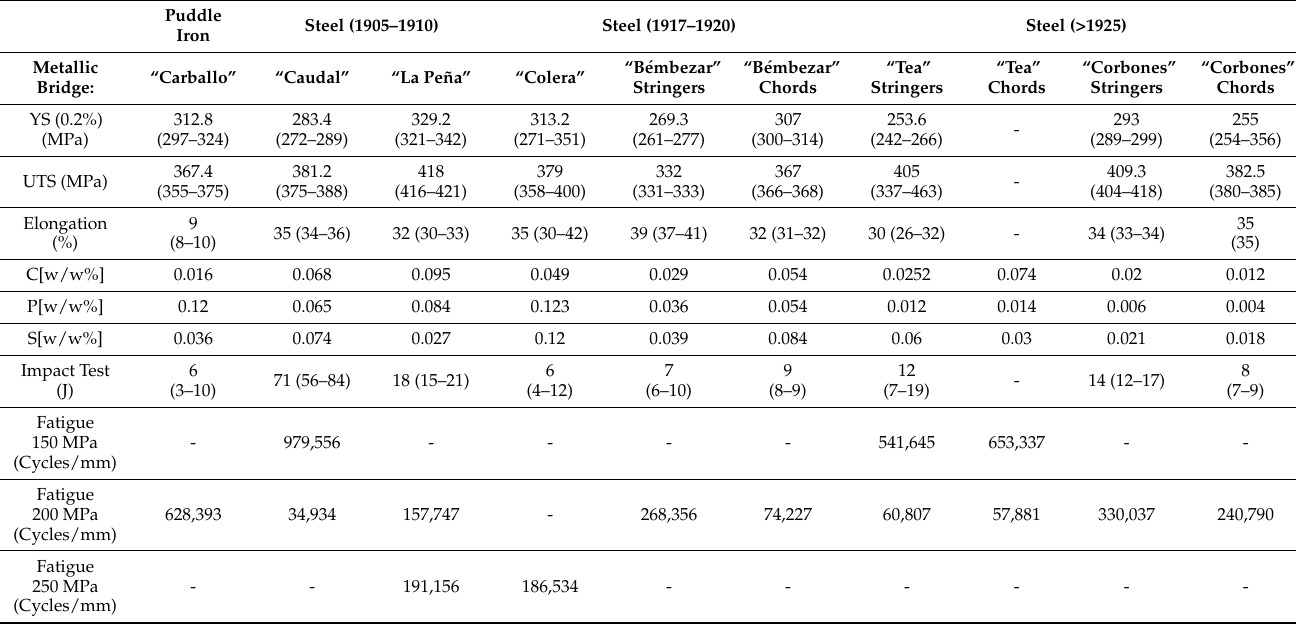
Table 8. Summary results for the seven metal